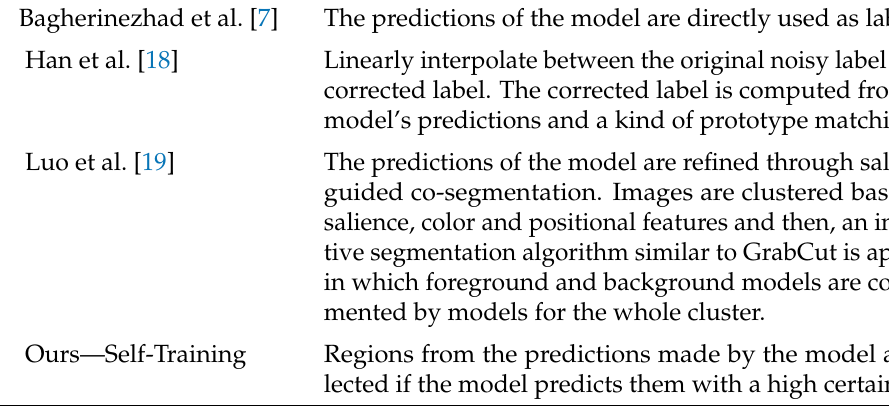
Table 2. Comparison of different approaches to self-training for label noise reduction. Bagherinezhad et al.